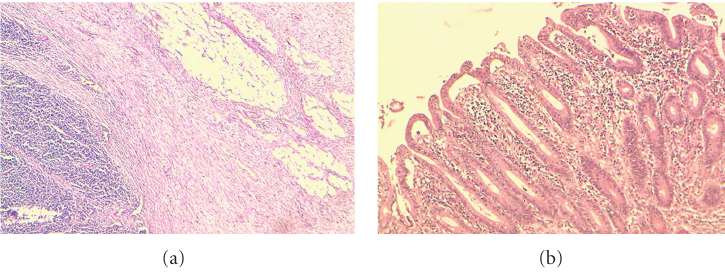
Figure 3: Histology of surgical specimen revealing (a) moderately di ff erentiated adenocarcinoma of duodenum, (b) total villous atrophy, crypt hyperplasia, and inflammatory cells in adjacent mucosa—Marsch